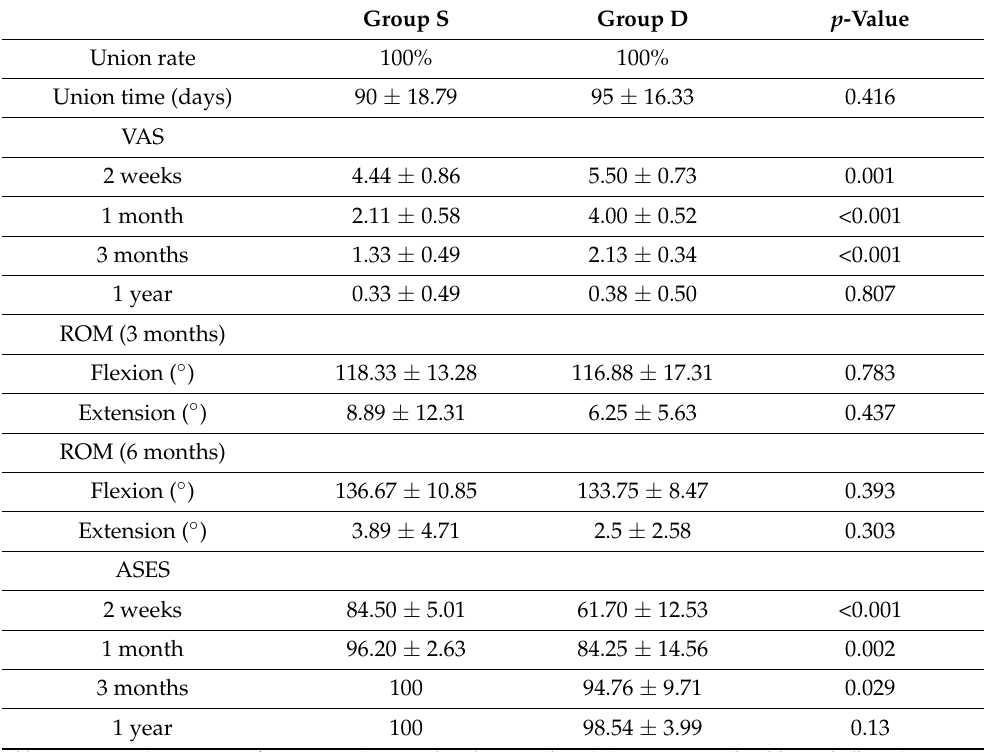
Table 3. Clinical